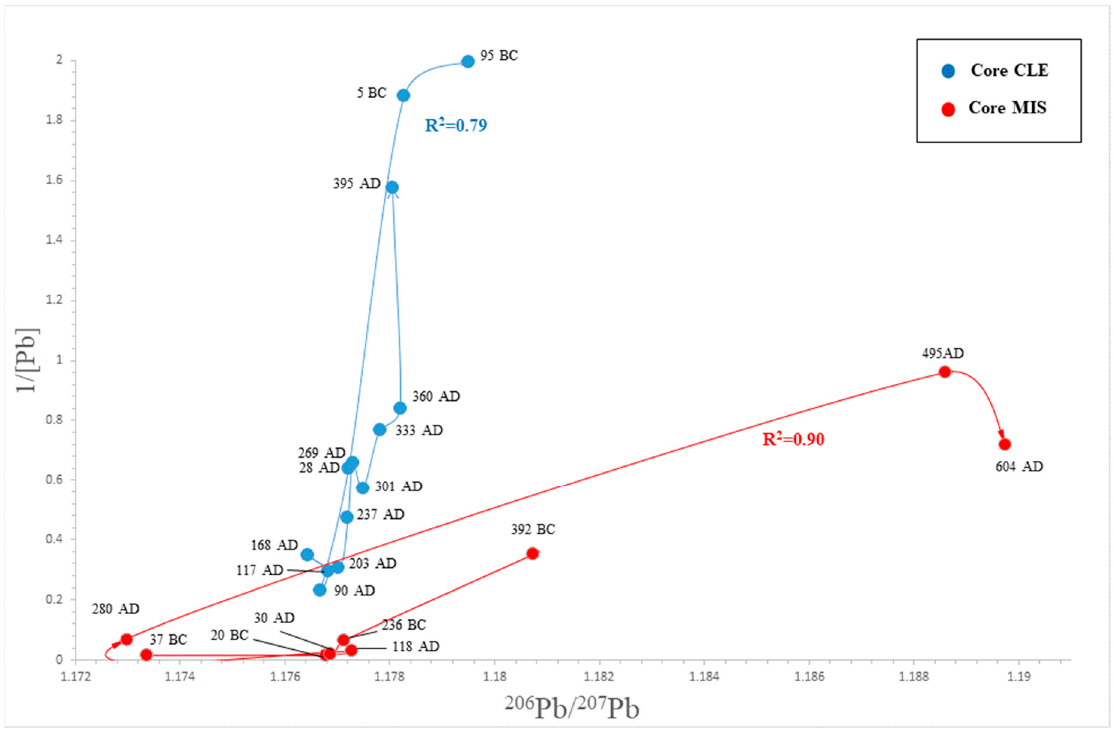
Figure 4. Evolution of 206 Pb/ 207 Pb ratios in CLE and MIS core samples versus 1/[Pb].